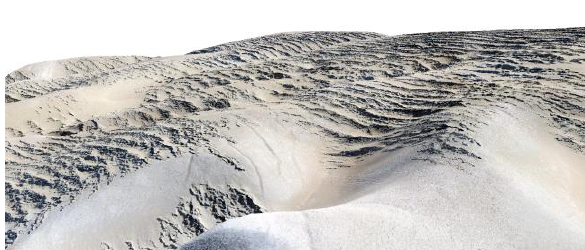
Figure 2. Subset of the digital surface model of the “Oryabide” local focus site with draped 3 cm-resolution orthomosaics.